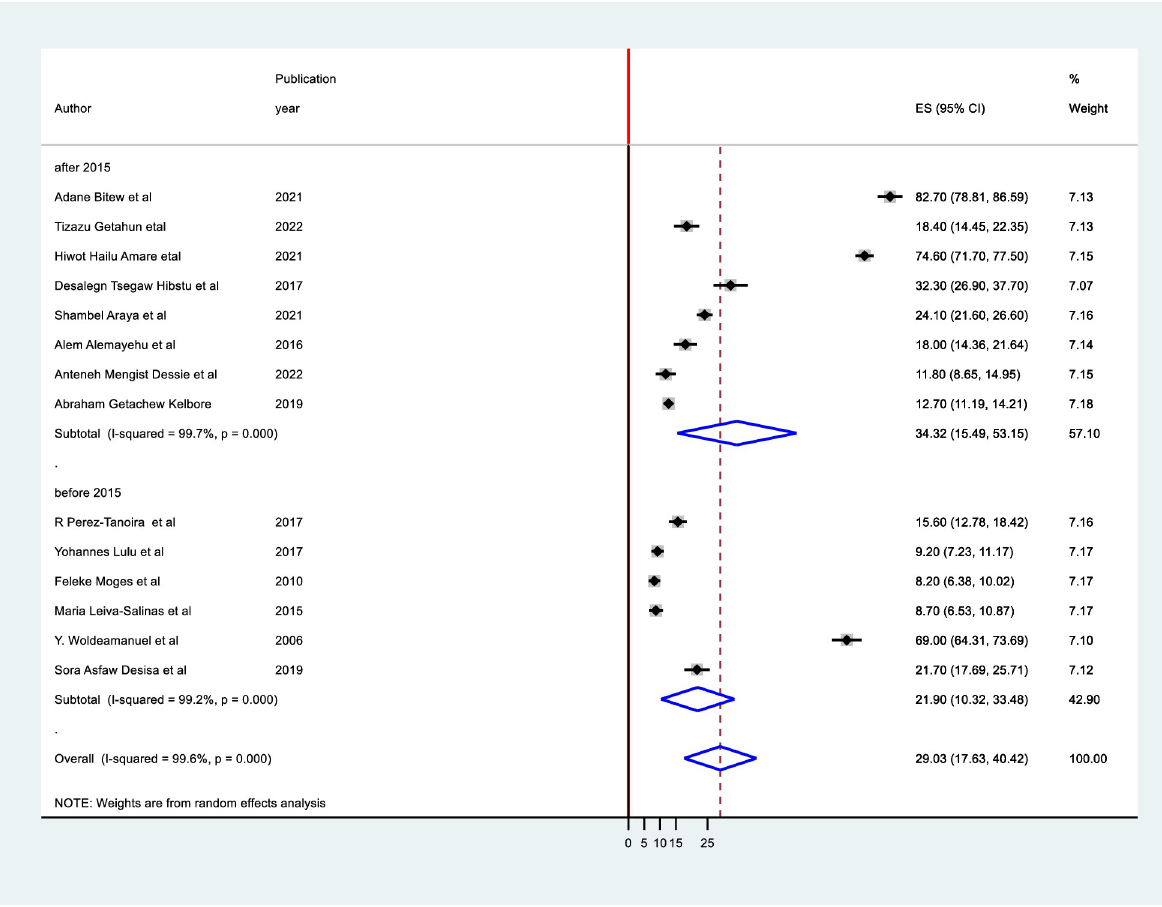
Fig 5. Subgroup meta nalysis of tinea capitis on sample size of Ethiopian schoolchildren.